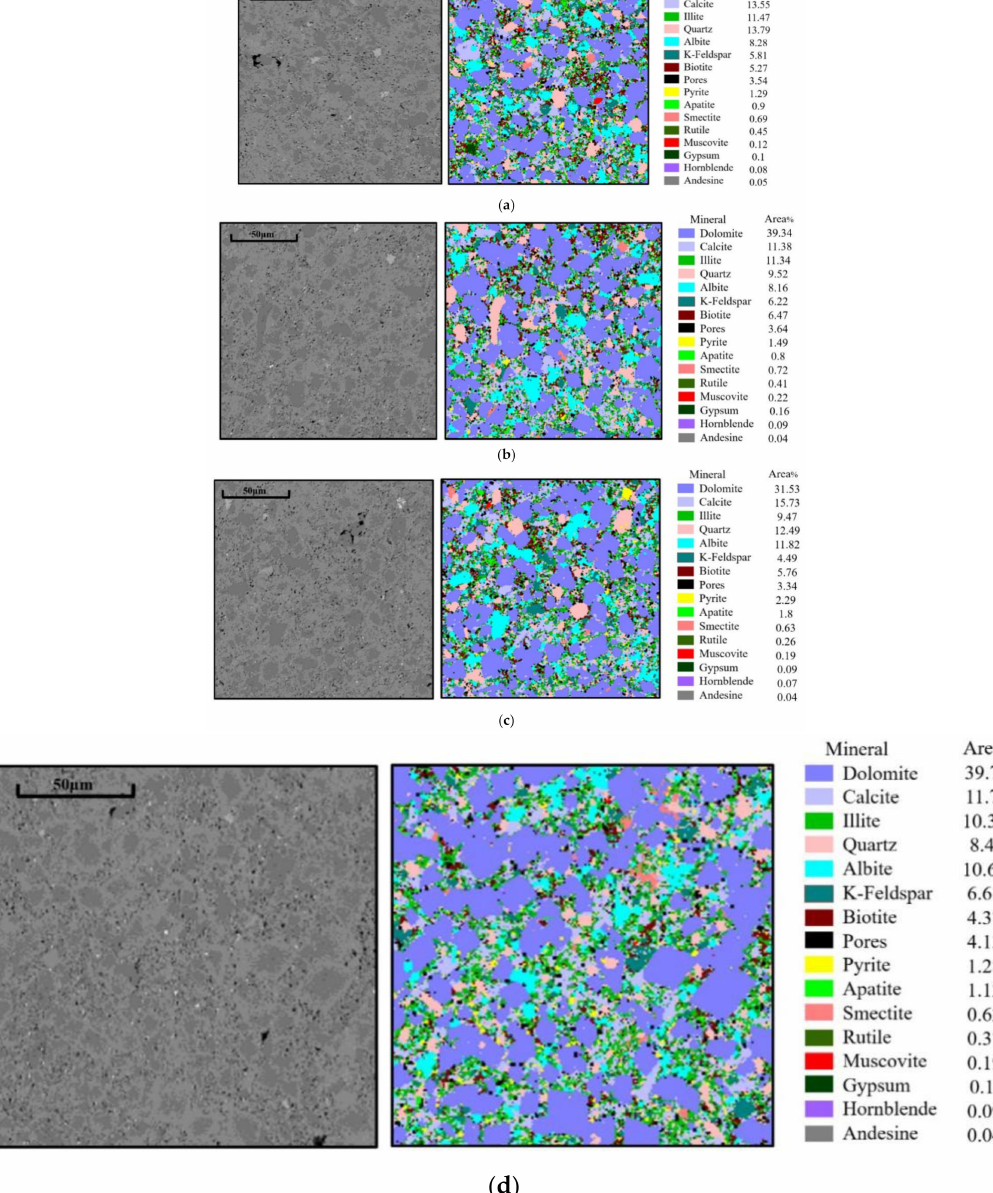
Figure 4. Mineral distribution under QEMSCAN: ( a ) nanoindentation grid 1, ( b ) nanoindentation grid 2, ( c ) nanoindentation grid 3, ( d ) nanoindentation grid